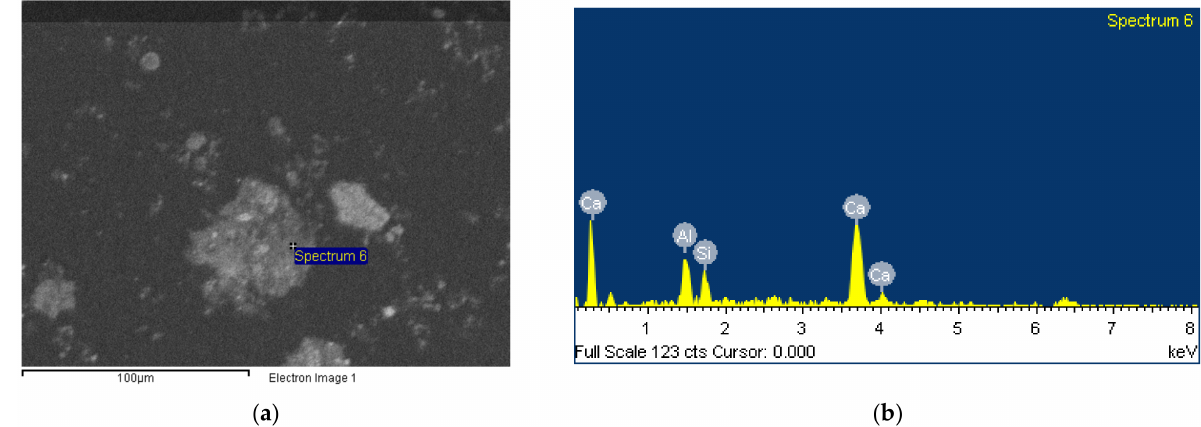
Figure 5. SEM of AoG sample—( a ) image of hematite phase. ( b ) EDS of hematite phase.